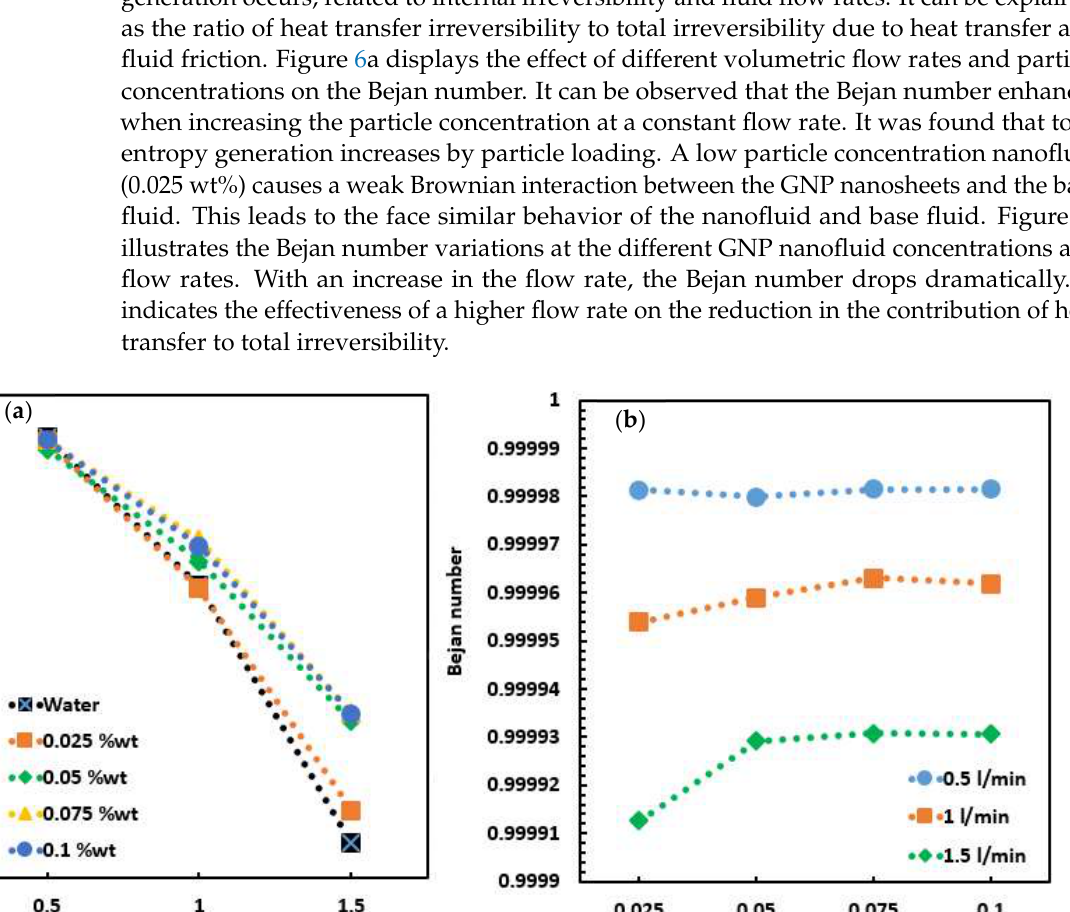
Figure 5. ( a ) Variation of exergy destruction with respect to mass flow and concentration and ( b ) effect of volumetric flow rate on entropy generation.